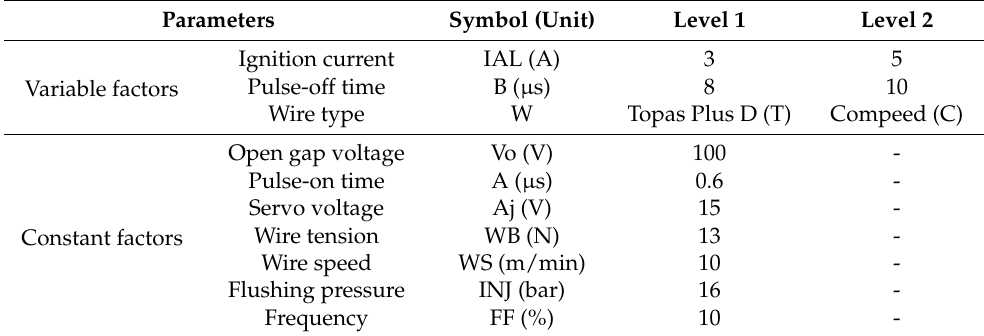
Table 2. Variable and constant parameters.